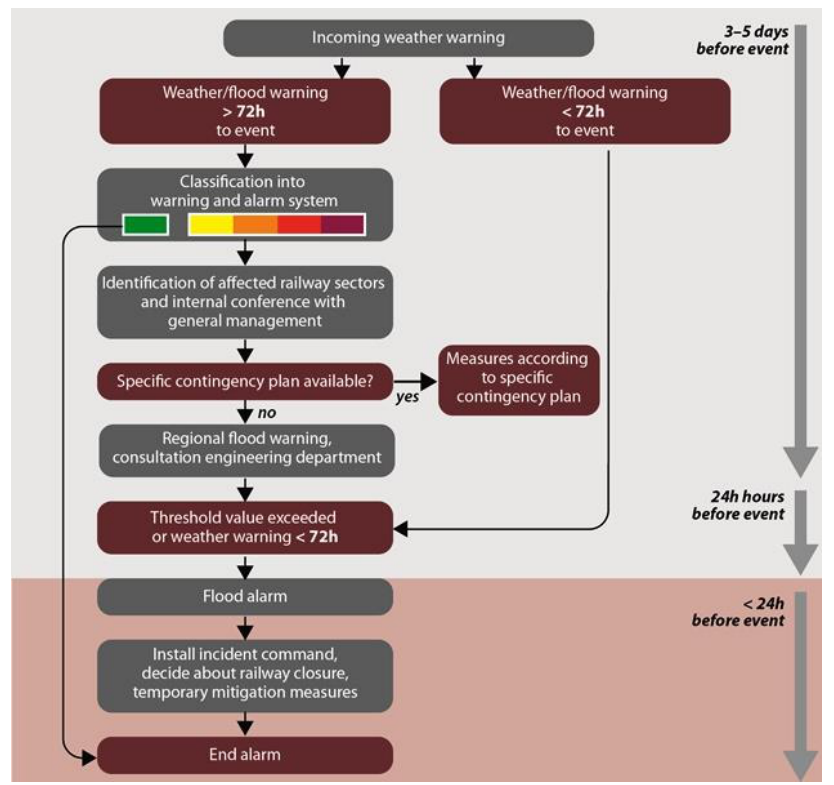
Figure 1. Flowchart of procedures in case a threshold value for a CMC is exceeded and a weather warning (and/or flood warning) is issued. (Source: Ö BB).